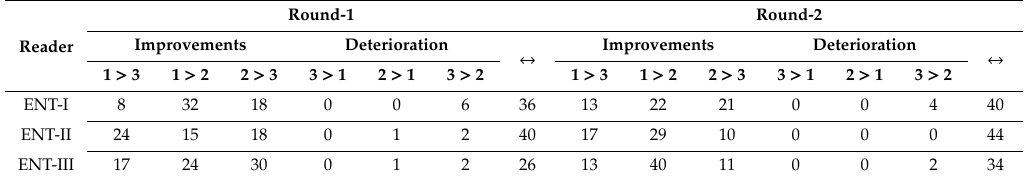
Table 2. Changes in scores on the evaluation of SelectStitch composite images compared to base process composite images over two rounds for three experts where the symbol of > means “to”; the symbol of ↔ represents no change cases.